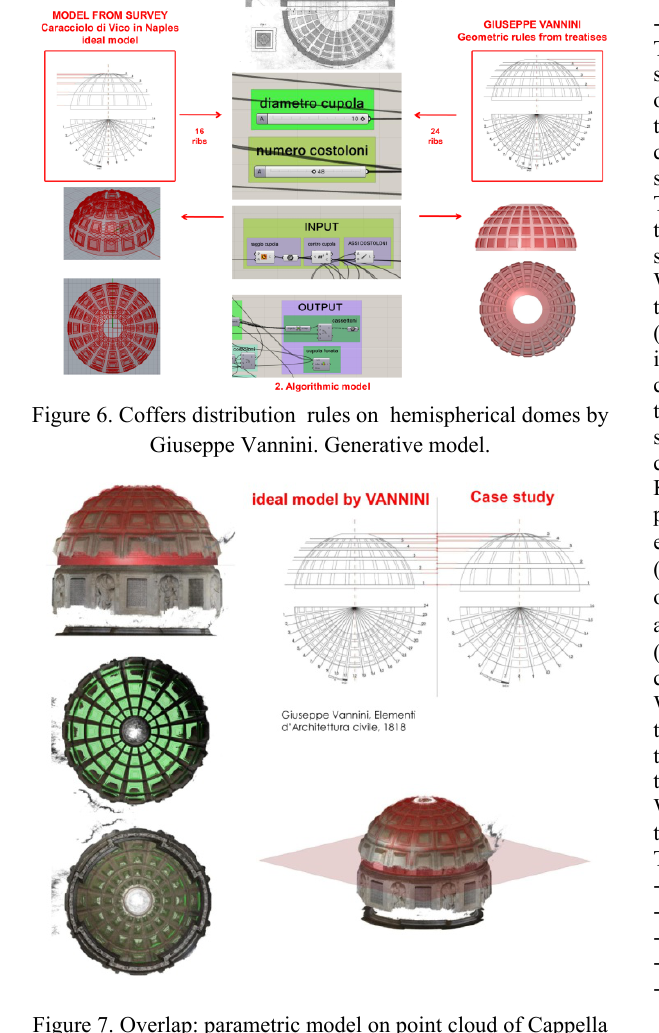
Figure 7. Overlap: parametric model on point cloud of Cappella Caracciolo di Vico in Naples.